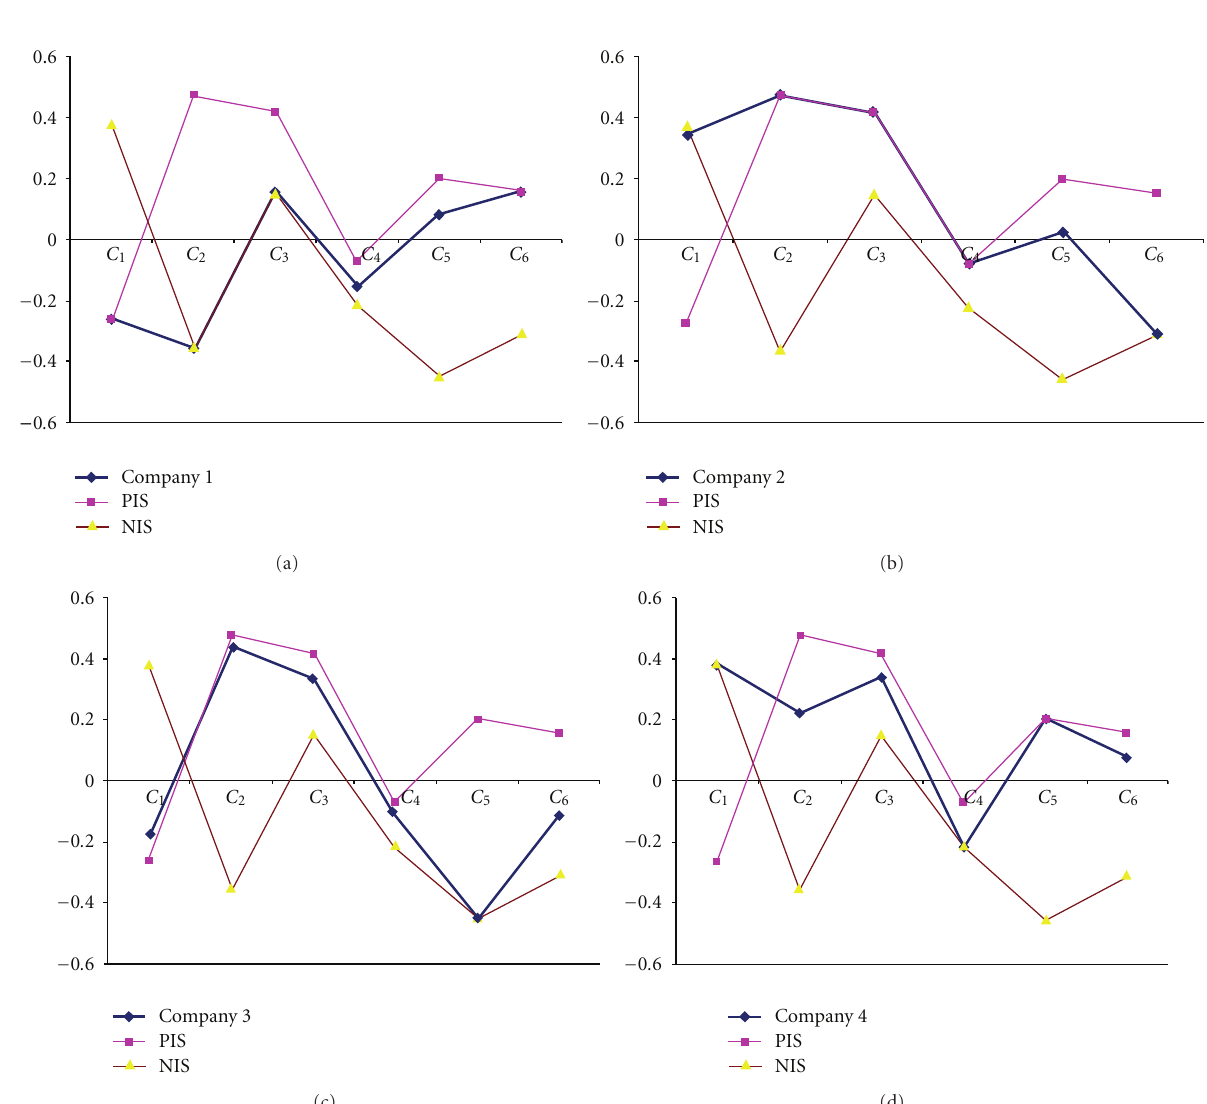
Figure 2: Comparison between each company and IVIF PIS and IVIF